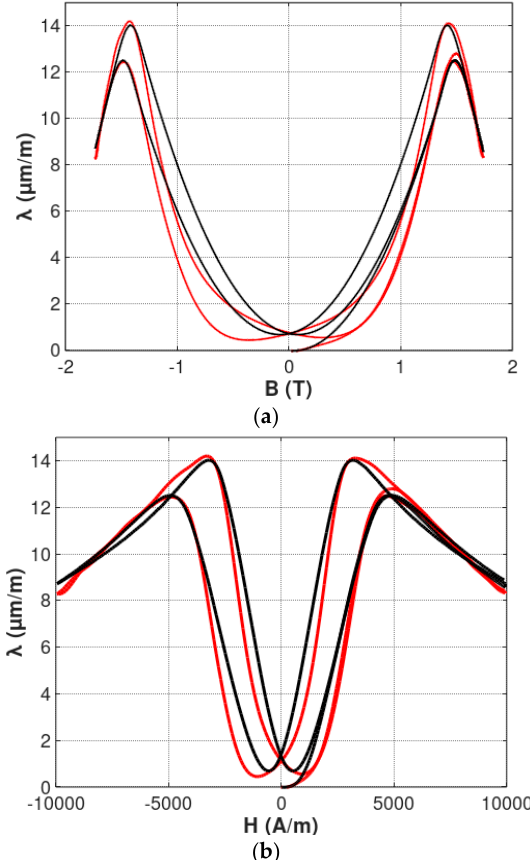
Figure 8. Results of modeling the magnetostrictive hysteresis loops of 13CrMo4-5 steel: ( a ) λ (B) hysteresis loop; ( b ) λ (H) hysteresis loop. Experimental results—red line; results of modeling—black line.